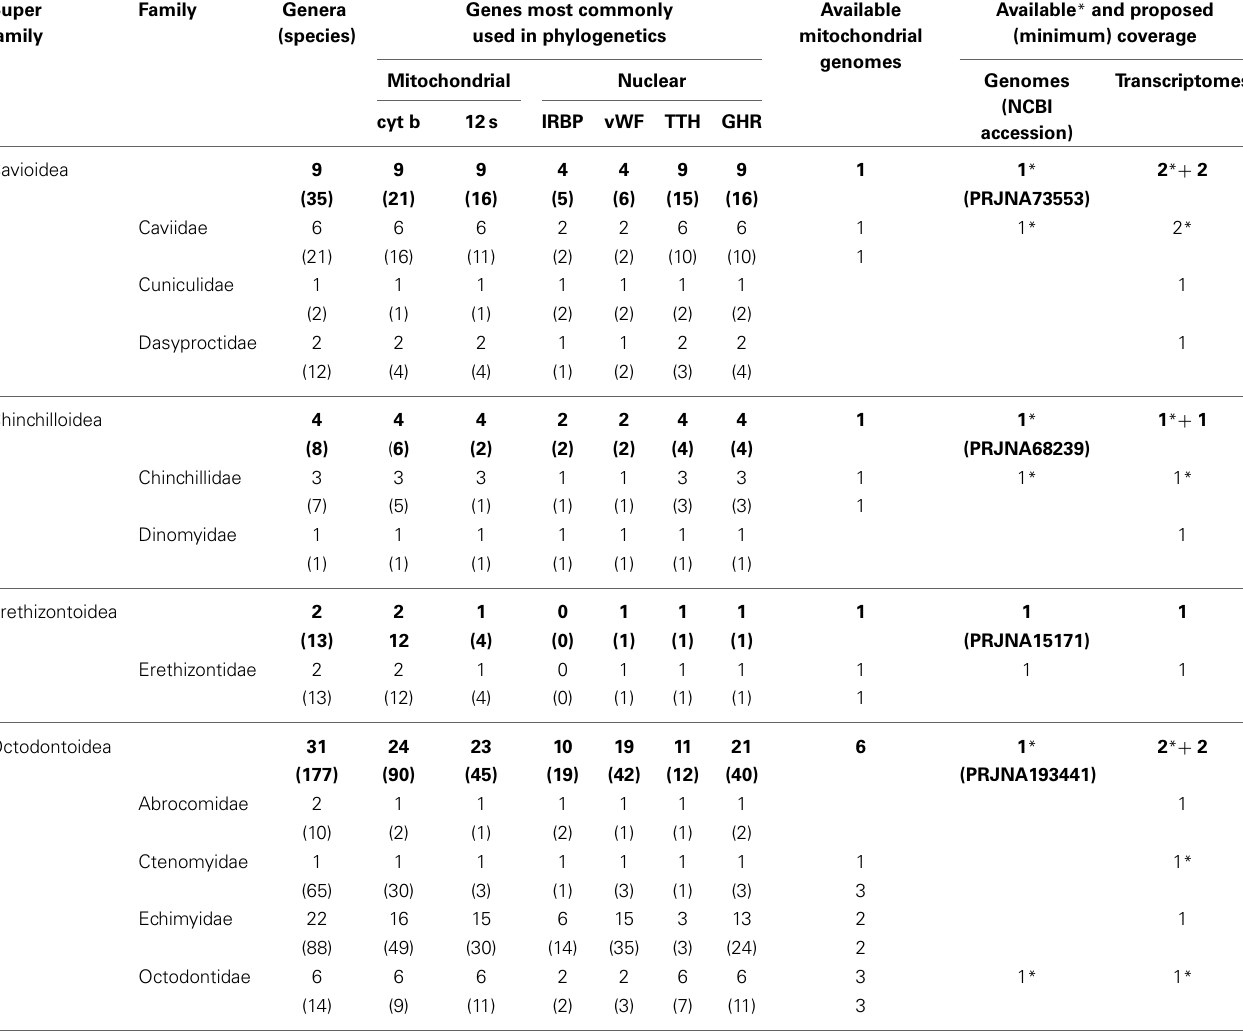
Table 1 | Classification and diversity (number of species and genera per family) of caviomorph rodents in South America (following Patton et al., in press), with a survey of the available taxonomic coverage for the most commonly used loci in caviomorph phylogenetic studies, and available and proposed genomic and transcriptomic